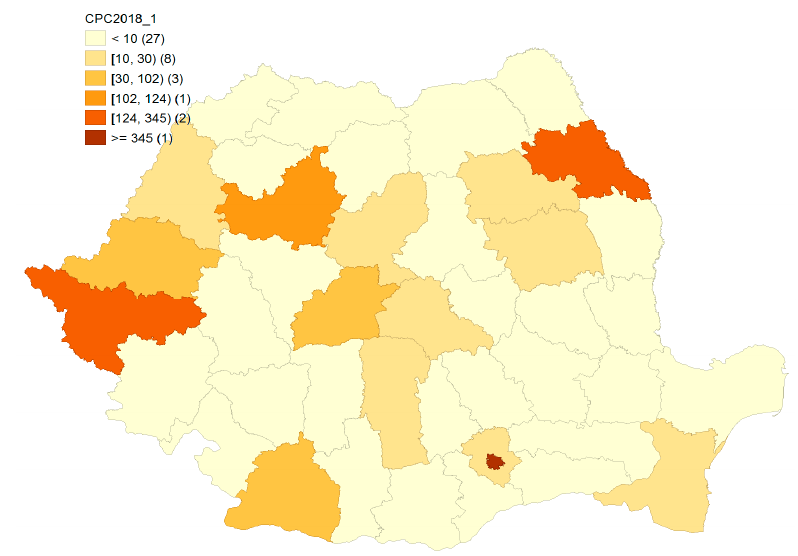
Figure 4. The map of CPC, 2018.